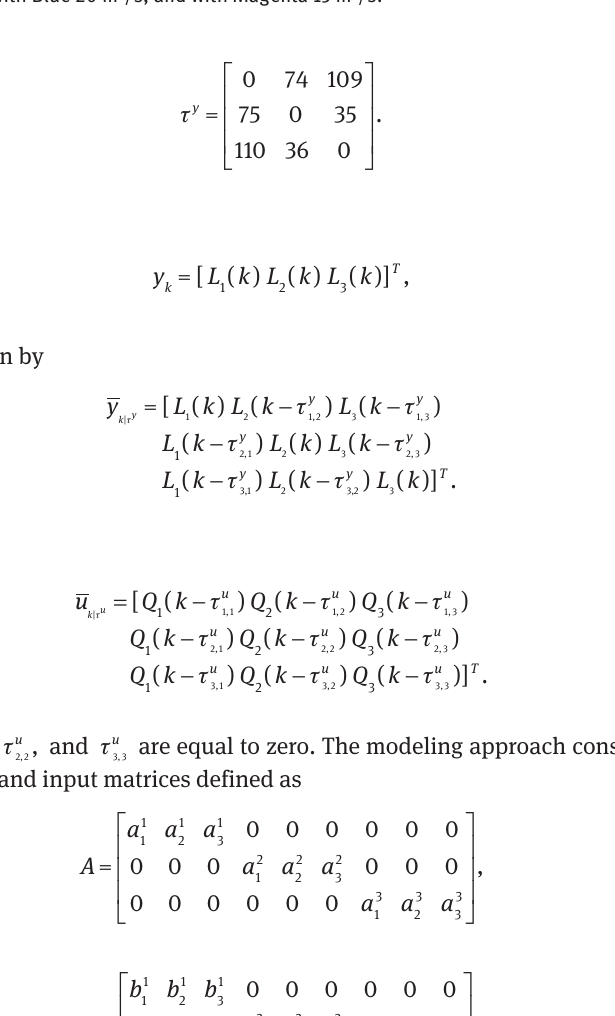
Figure 8. Fontinettes Lock Operations for Different Discharge Schedules. With Black, an Operation with Maximum of 30 m 3 /s Discharge, with Red 25 m 3 /s, with Blue 20 m 3 /s, and with Magenta 15 m 3